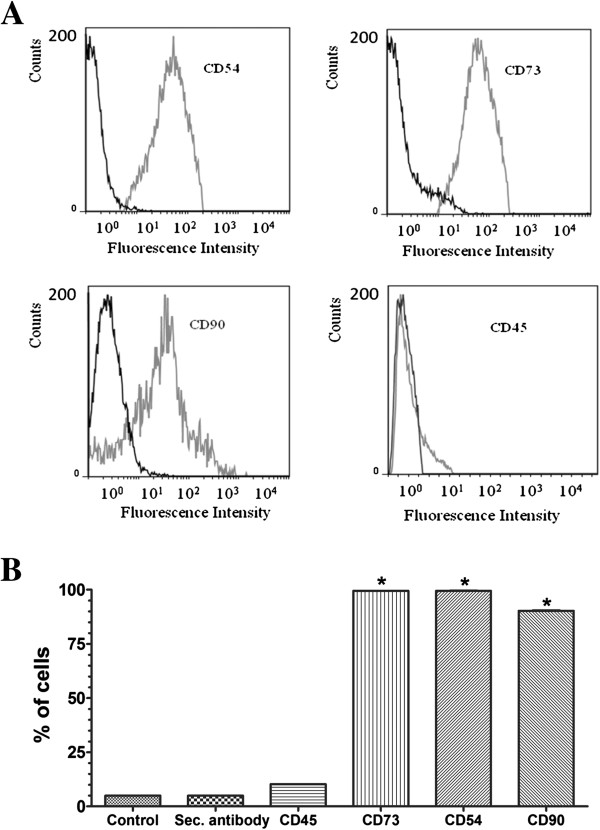
Phenotypic analysis of rat MSCs. (A) FACS analysis of CD45, CD54, CD73, and CD90 antigens in rat MSCs (gray bars). Solid black bars refer to the negative controls (cells incubated with isotype IgG control and secondary antibody). (B) Quantitative analysis of the expression pattern of rat MSCs. The control group comprised cells that were not incubated with the Alexa Fluor 488-conjugated secondary antibody. The secondary antibody (sec. antibody) group comprised cells that were incubated with the isotype IgG control and secondary antibody alone. *P < 0.001 compared with control; N = 3 (three experiments that were conducted independently).